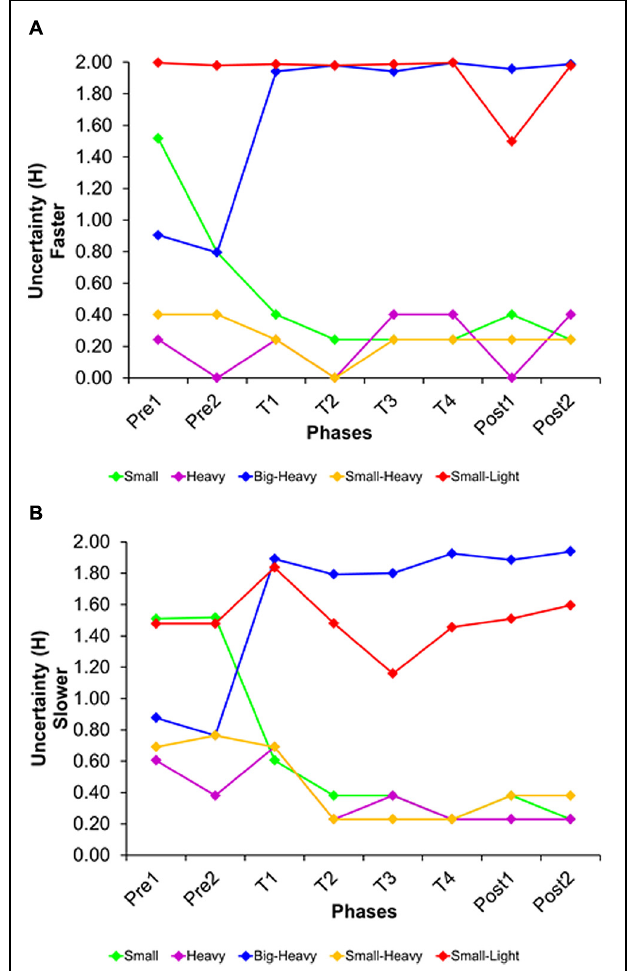
FIGURE 5 | Average proportion of correct responses, by trial type and segment, in the sink-faster (A) and the sink-slower condition (B). Error bars represent the standard errors.